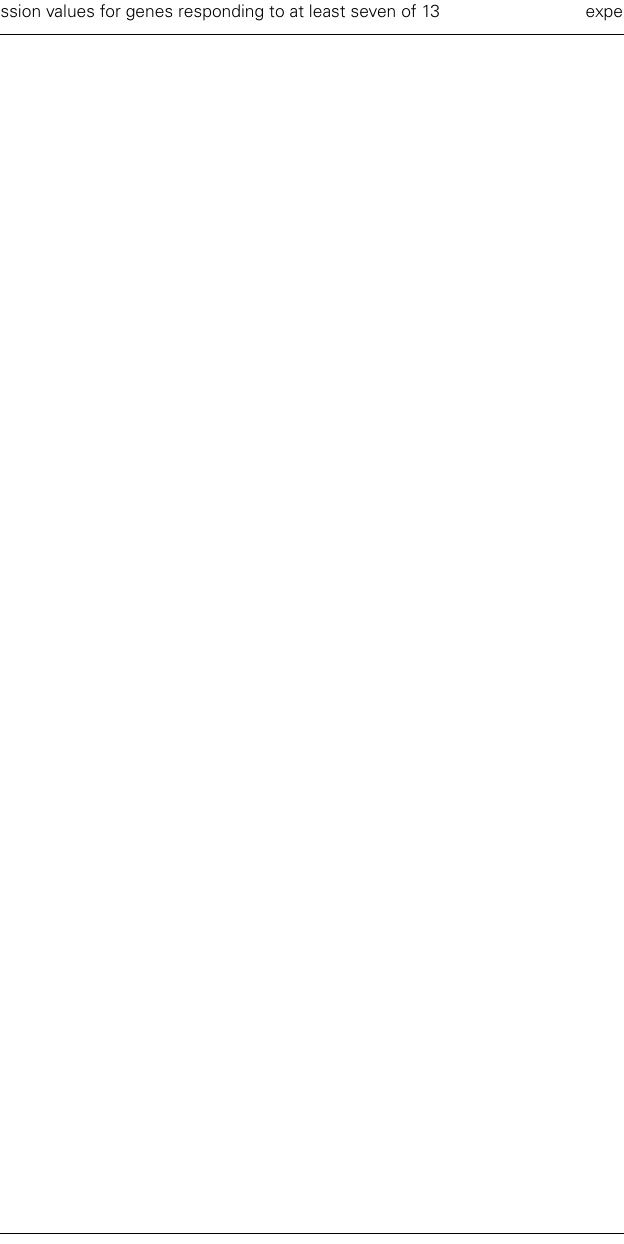
FIGUREA1 | Heat Map representing expression values of genes specifically responding to mitochondrial perturbations. Normalized expression values for genes responding to at least seven of 13